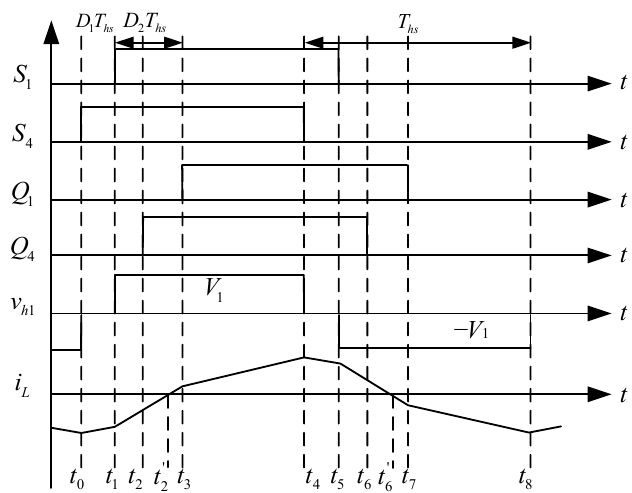
Figure 6. Waveform of dual phase shift control system.